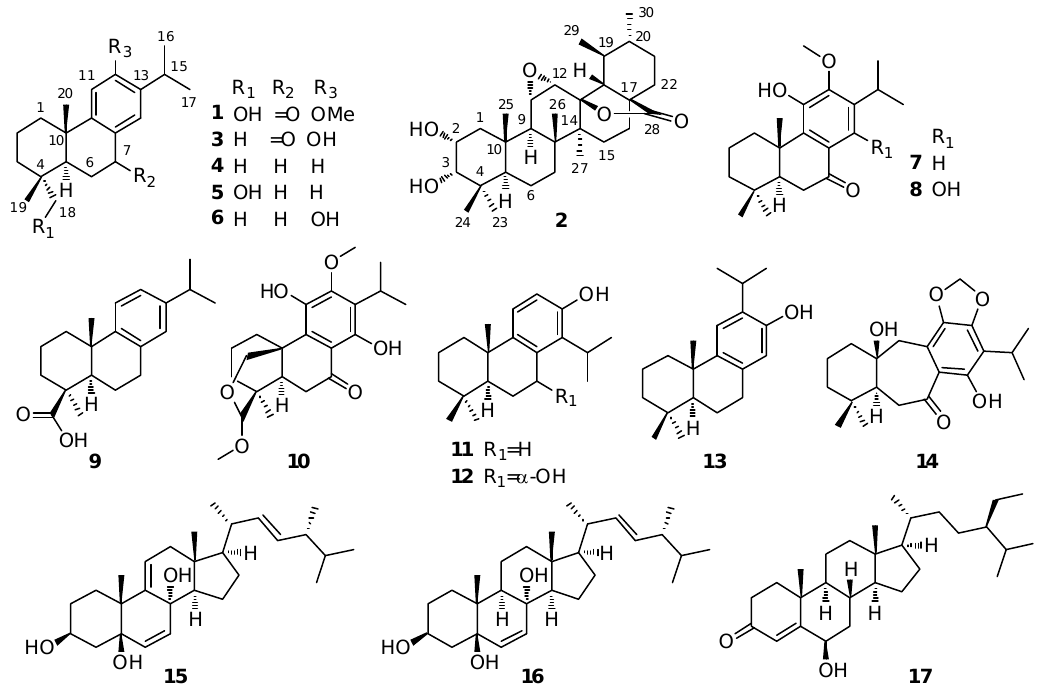
Figure 2. Chemical structures of compounds 1 – 17 from roots of D. taliense .